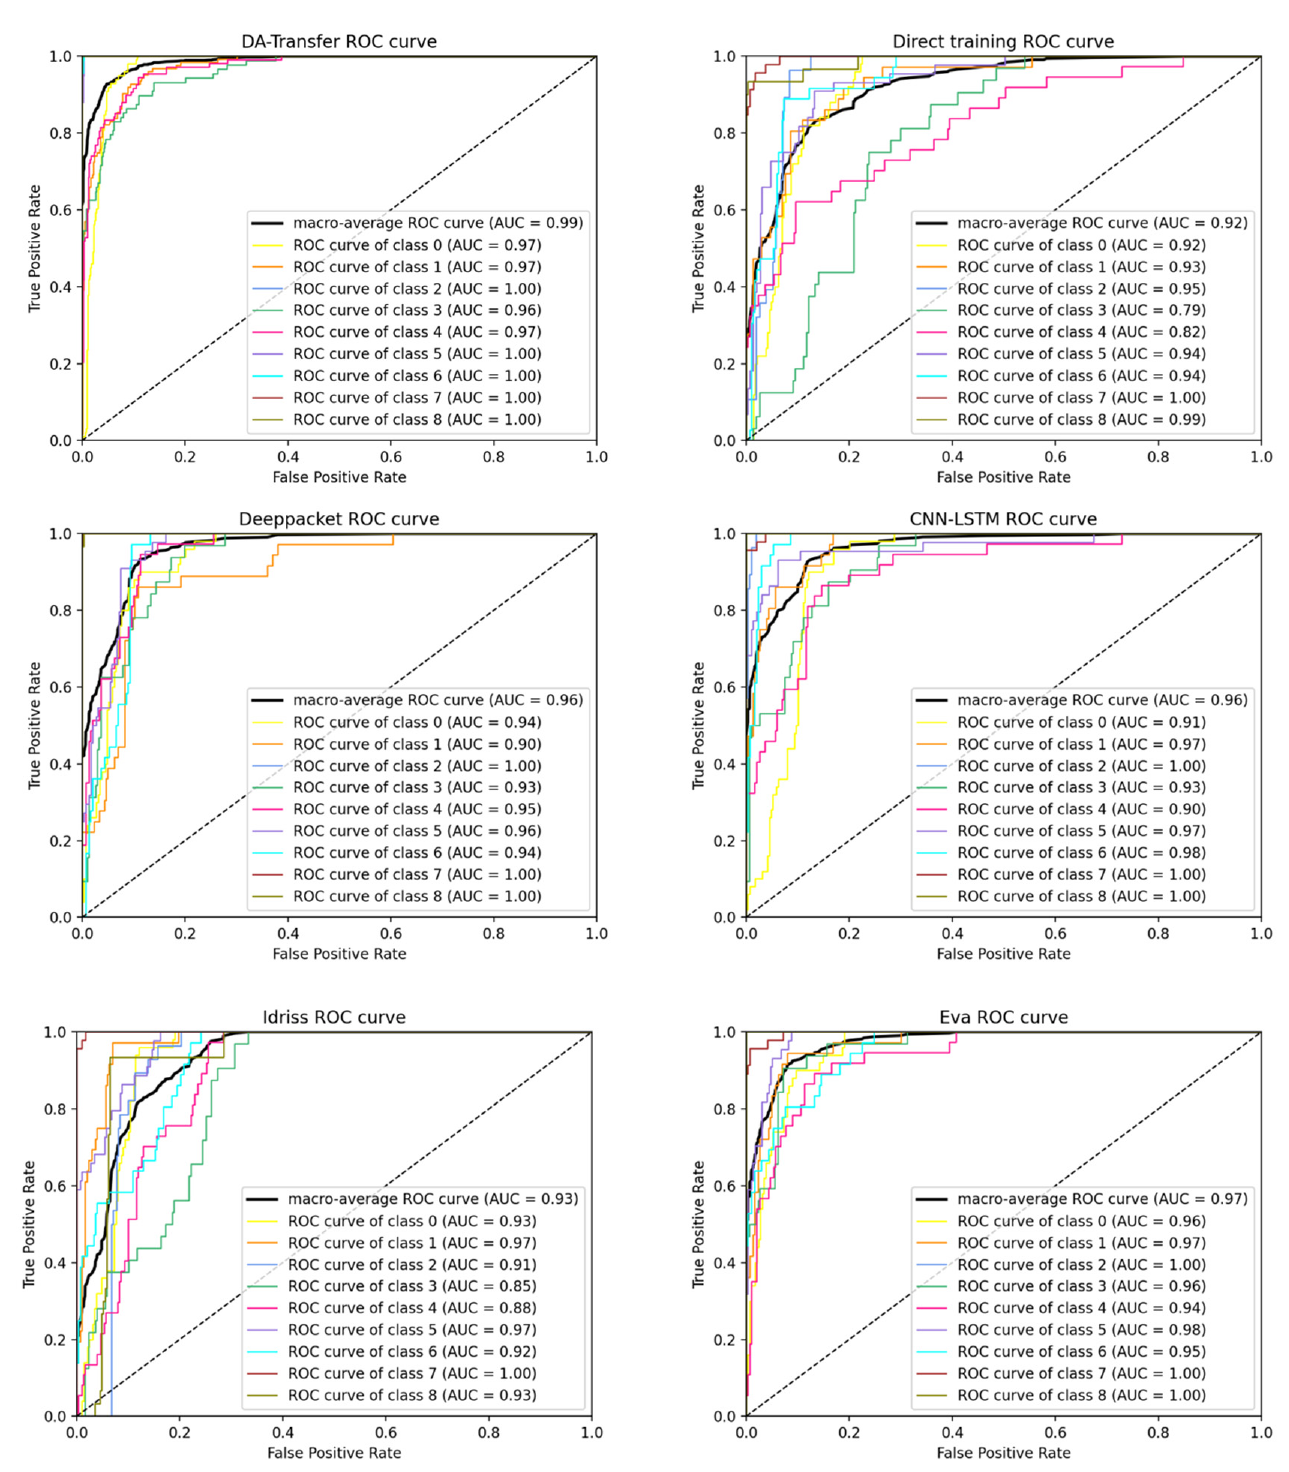
Figure 6. ROC curve of six traffic classification methods: DA-Transfer, direct training, Deeppacket, CNN-LSTM, Idriss, and Eva.